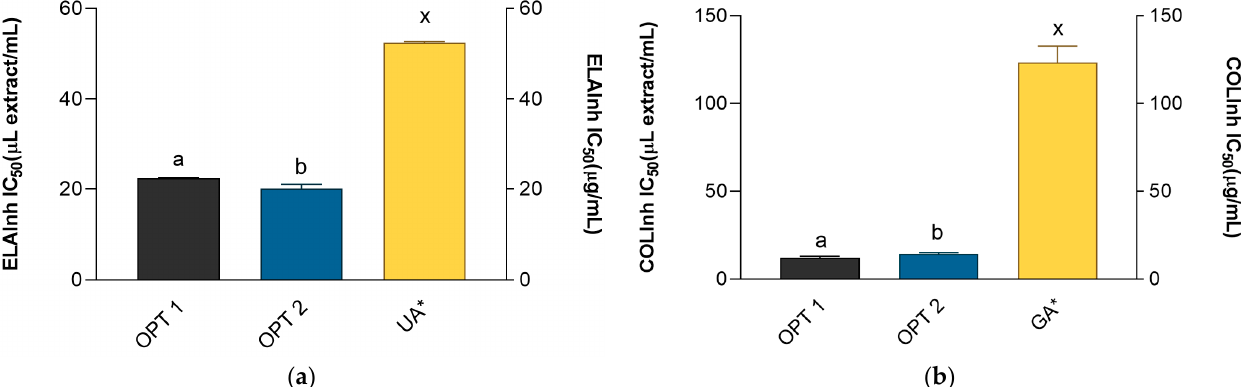
Figure 5. Inhibitory activity of the extracts and corresponding positive controls: ursolic acid (UA) and gallic acid (GA) on ( a ) elastase and ( b ) collagenase. The activities are shown as IC 50 values ± SD. a,b = differences between the extracts within a column ( t -test, p < 0.05). x = differences with the positive control (Dunnett’s post-test, p < 0.05). Columns not connected with the same letter are statistically different. Asterisk indicates that the unit is placed at the right ordinate.